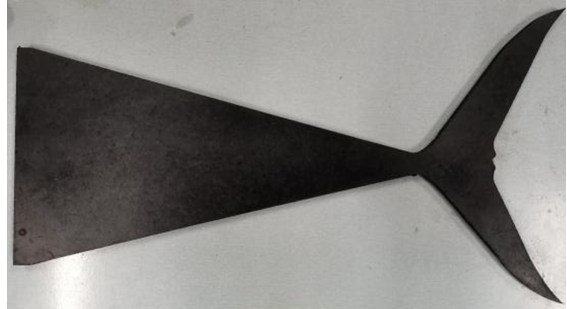
Figure 3. A thin rubber tail made from the shape of a real tuna.